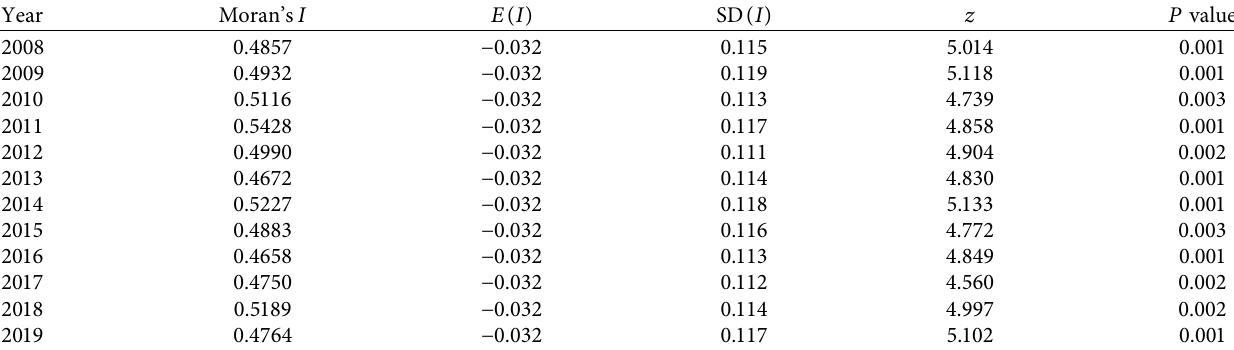
Table 2: Global Moran’s I statistical indicators of economic growth in 31 provinces in China from 2008 to 2019.